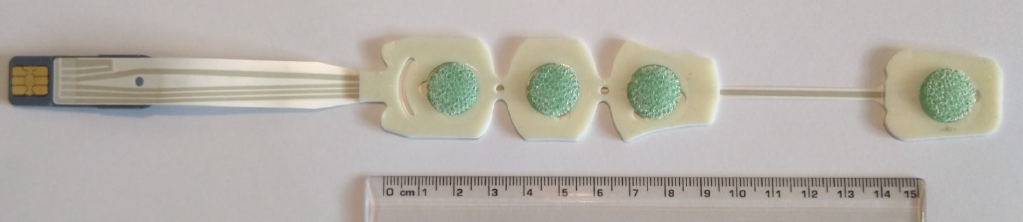
Figure 1. BIS ‐ Quatro TM pre ‐ gelled sensor system showing dimensions. Figure 1. BIS-Quatro TM pre-gelled sensor system showing